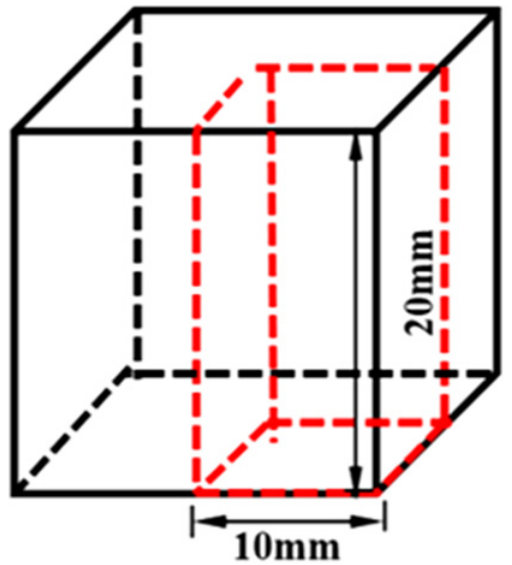
Figure 10. Geometry of specimens under investigation.